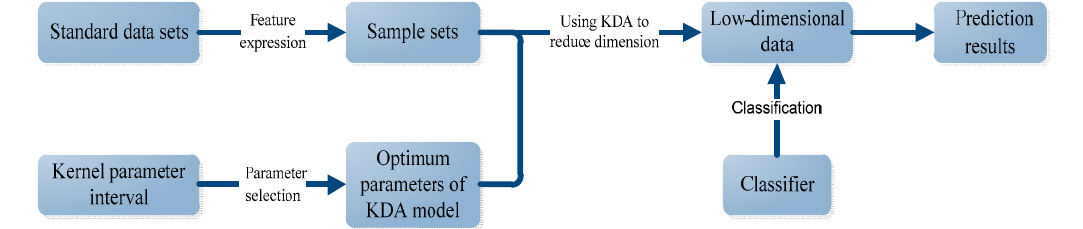
Figure 5. The flow of protein subcellular localization.